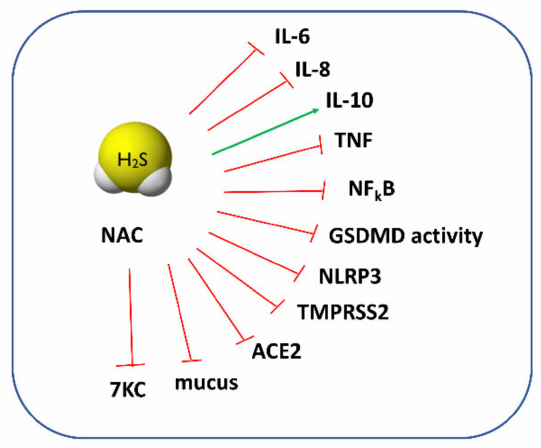
Figure 5. Potential protective role of H 2 S and NAC against COVID-19. H 2 S and NAC exert anti- inflammatory action through inhibition of NLRP3 inflammasome activity, GSDMD activity, reduction of proinflammatory cytokine production (IL-6 and IL-8), an increase in anti-inflammatory cytokine IL-10. The activity of tumor necrosis factor (TNF) and transcription factor NF k B can also be inhibited by H 2 S and NAC. H 2 S and NAC can block the entry of SARS-CoV-2 into host cells by suppressing the transmembrane serine protease 2 (TMPRSS2) activity and the receptor angiotensin-converting enzyme 2 (ACE2) activity. Moreover, NAC and H 2 S can modulate mucolytic activity and make the mucus less viscous and reduce the level of 7-ketocholesterol